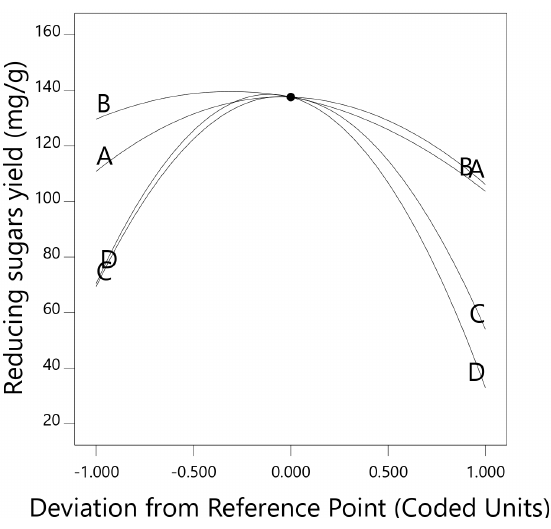
Figure 2. Perturbation plot with all factors.